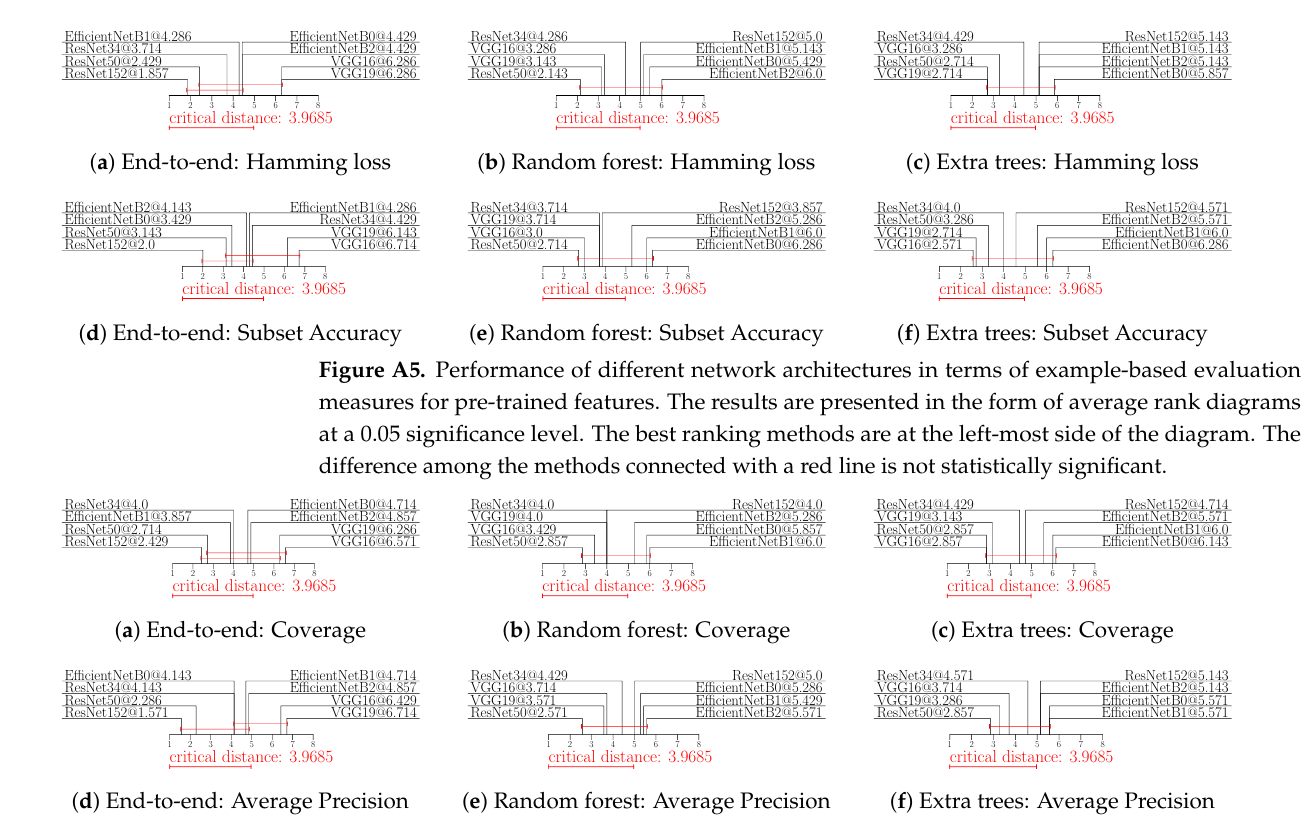
Figure A6. Performance of different network architectures in terms of ranking-based evaluation measures for pre-trained features. The results are presented in the form of average rank diagrams at a 0.05 significance level. The best ranking methods are at the left-most side of the diagram. The difference among the methods connected with a red line is not statistically significant.